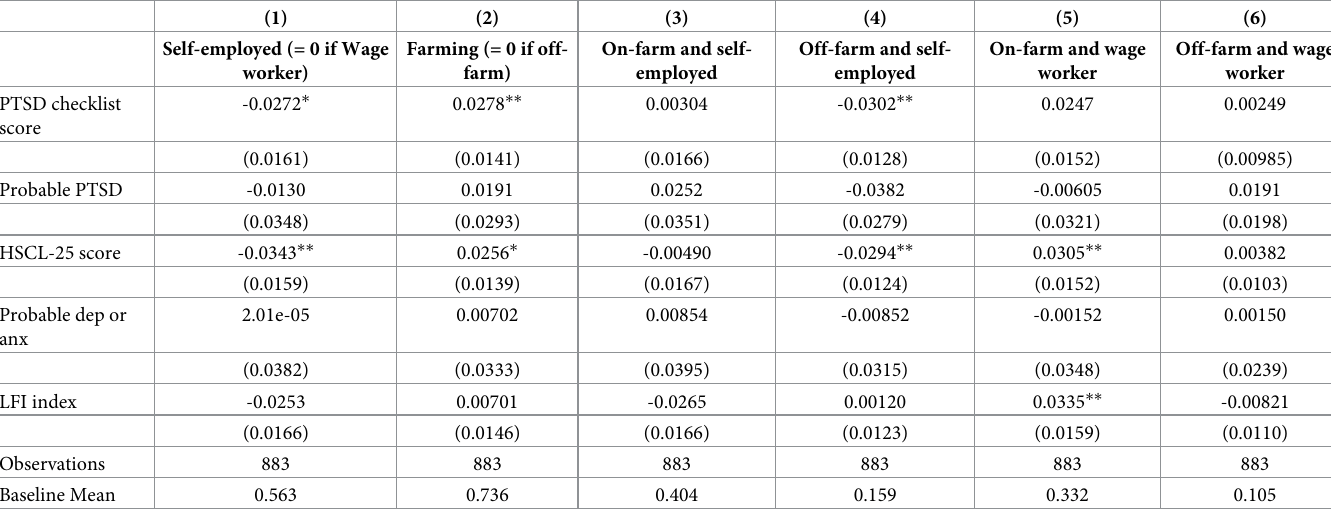
Table 11. Cross-section regressions of women’s employment sector and status and mental health